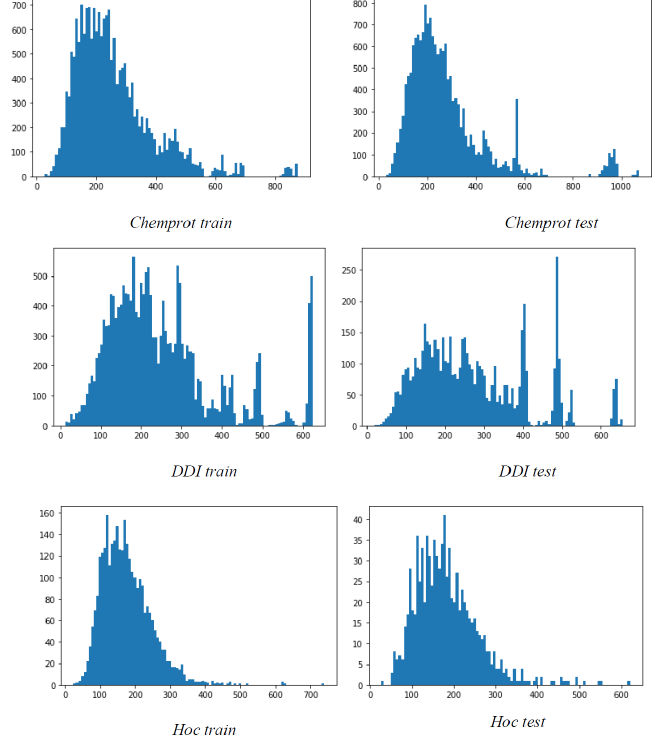
Figure 3. Data analysis of the datasets used in this study.